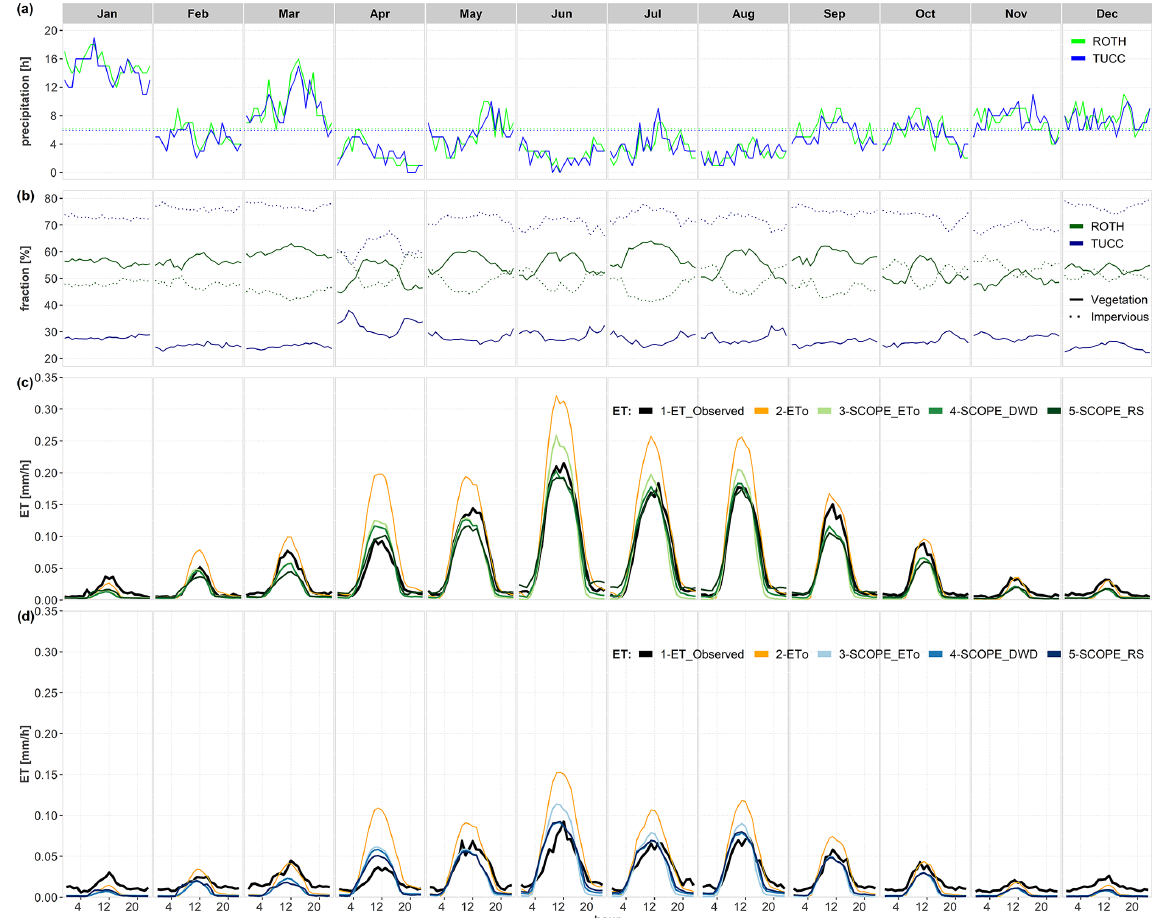
Figure 4. Hourly averages per month in 2019 for: (a) precipitation events; (b) percentage of the vegetation fraction (solid line) and imper- vious fraction (dashed lines); (c) predictions for the ROTH site; and (d) predictions for the TUCC site. The observed ET (black line) and corrected ET 0 (orange line) for both sites. The corrected SCOPE predictions are represented by green lines for ROTH and blues for the TUCC site. The light to dark colours represent SCOPE_ET 0 , SCOPE_DWD and SCOPE_RS, respectively, for both